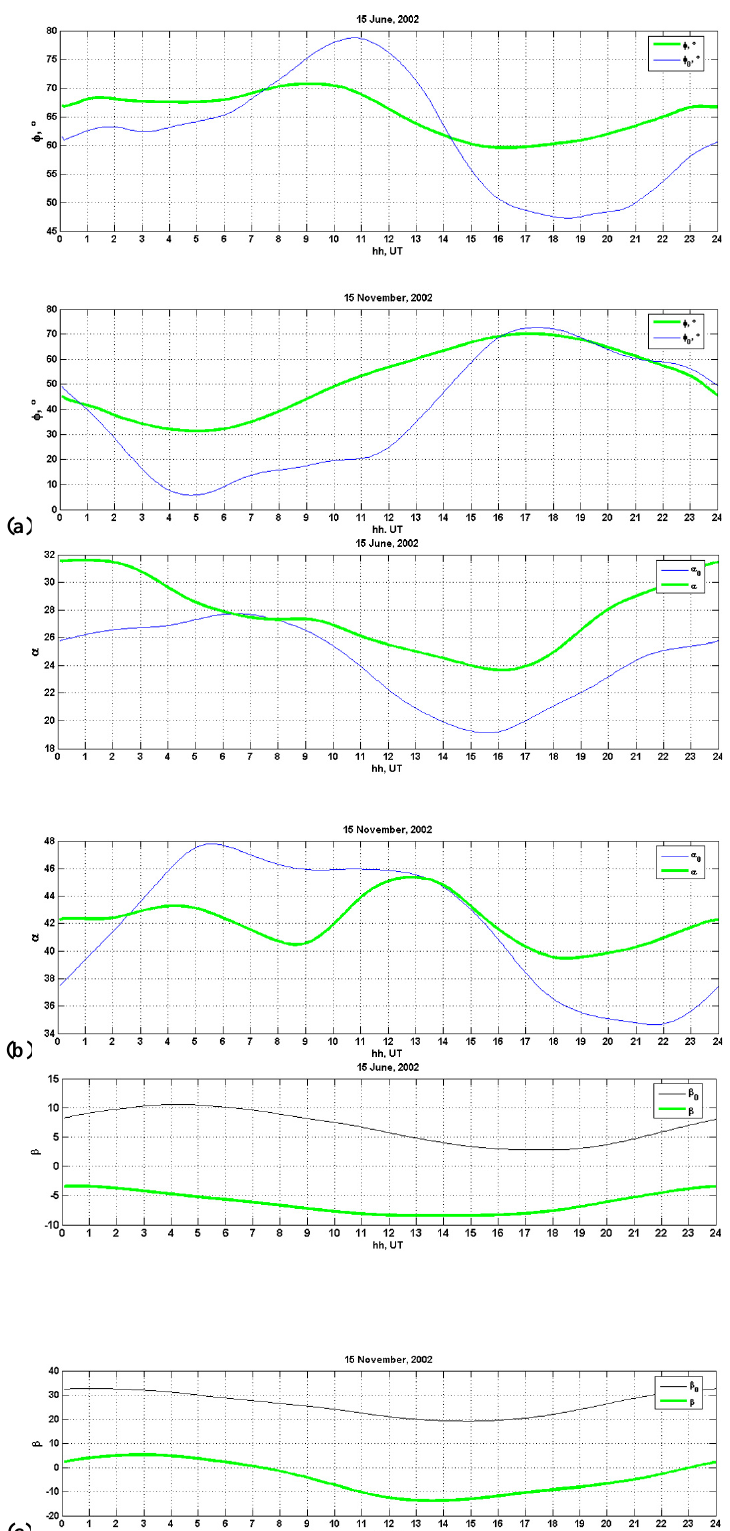
Fig. 1. Daily variation of angle φ 0 (a) , slope of regression line α 0 (b) , and intersection β 0 (c) derived without using QDC (thin lines) along with parameters φ , α , and β derived with inclusion of QDC (thick lines) for the same winter (15 June) and summer (15 November) days of 2002 at the Vostok